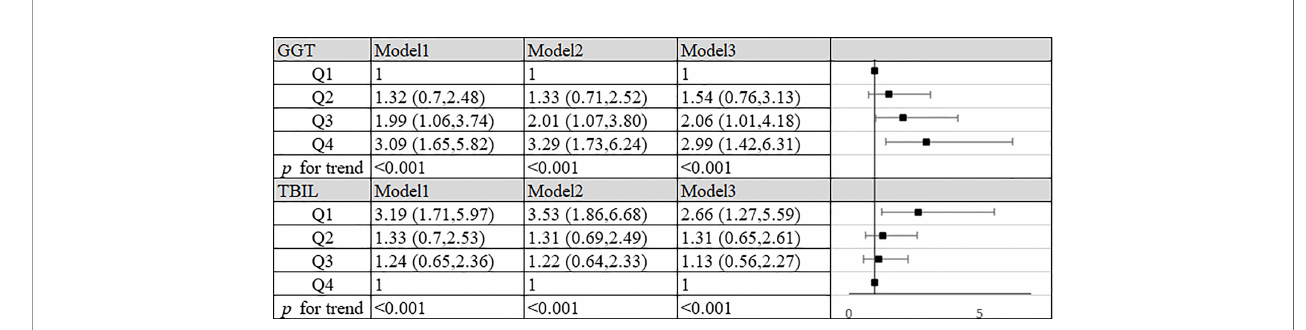
FIGURE 1 | Association of TBIL, GGT and aggravation of SLE in patients. Model 1: unadjusted. Model 2: adjusted for age, BMI, smoking status, alcohol consumption and estrogen level. Model 3: adjusted for age, BMI, smoking status, alcohol consumption, estrogen level, ALT, AST, SUA, CRP, IL-2, IL-4, IL-6, IL-10, TNF- a , hypertension, hyperlipidemia and diabetes mellitus. GGT: Q1, quartile 1 (n=89): ≤ 14 U/L; Q2, quartile 2 (n=88): 15-20 U/L; Q3, quartile 3 (n=82): 21-31 U/L; Q4, quartile 4 (n=82): >31 U/L. TBIL: Q1, quartile 1 (n=90): ≤ 8.3 mg/L; Q2, quartile 2 (n=83): 8.4-10.9 mg/L; Q3, quartile 3 (n=84): 11.0-13.8 mg/L; Q4, quartile 4 (n=84):